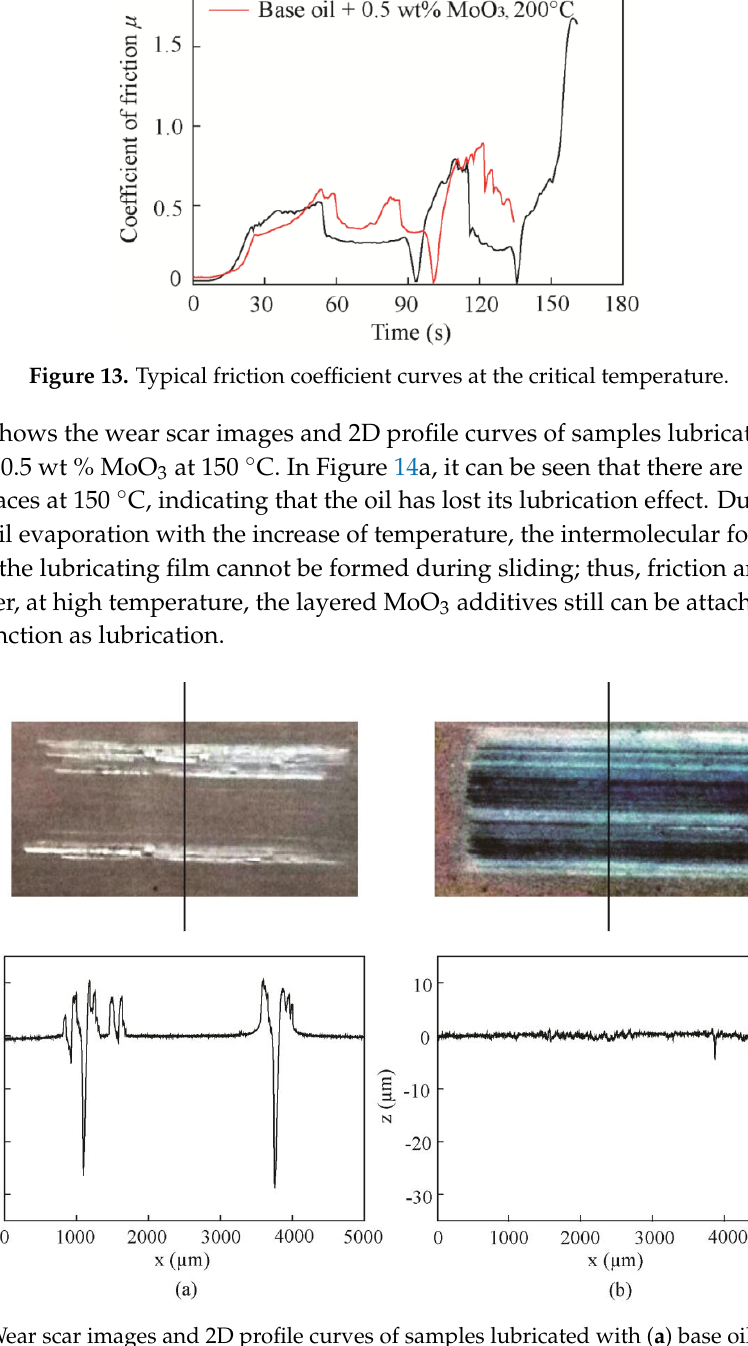
Figure 12. Average friction coefficient of the base oil and with 0.5 wt % micro-lamellar MoO 3 additives under different temperatures.